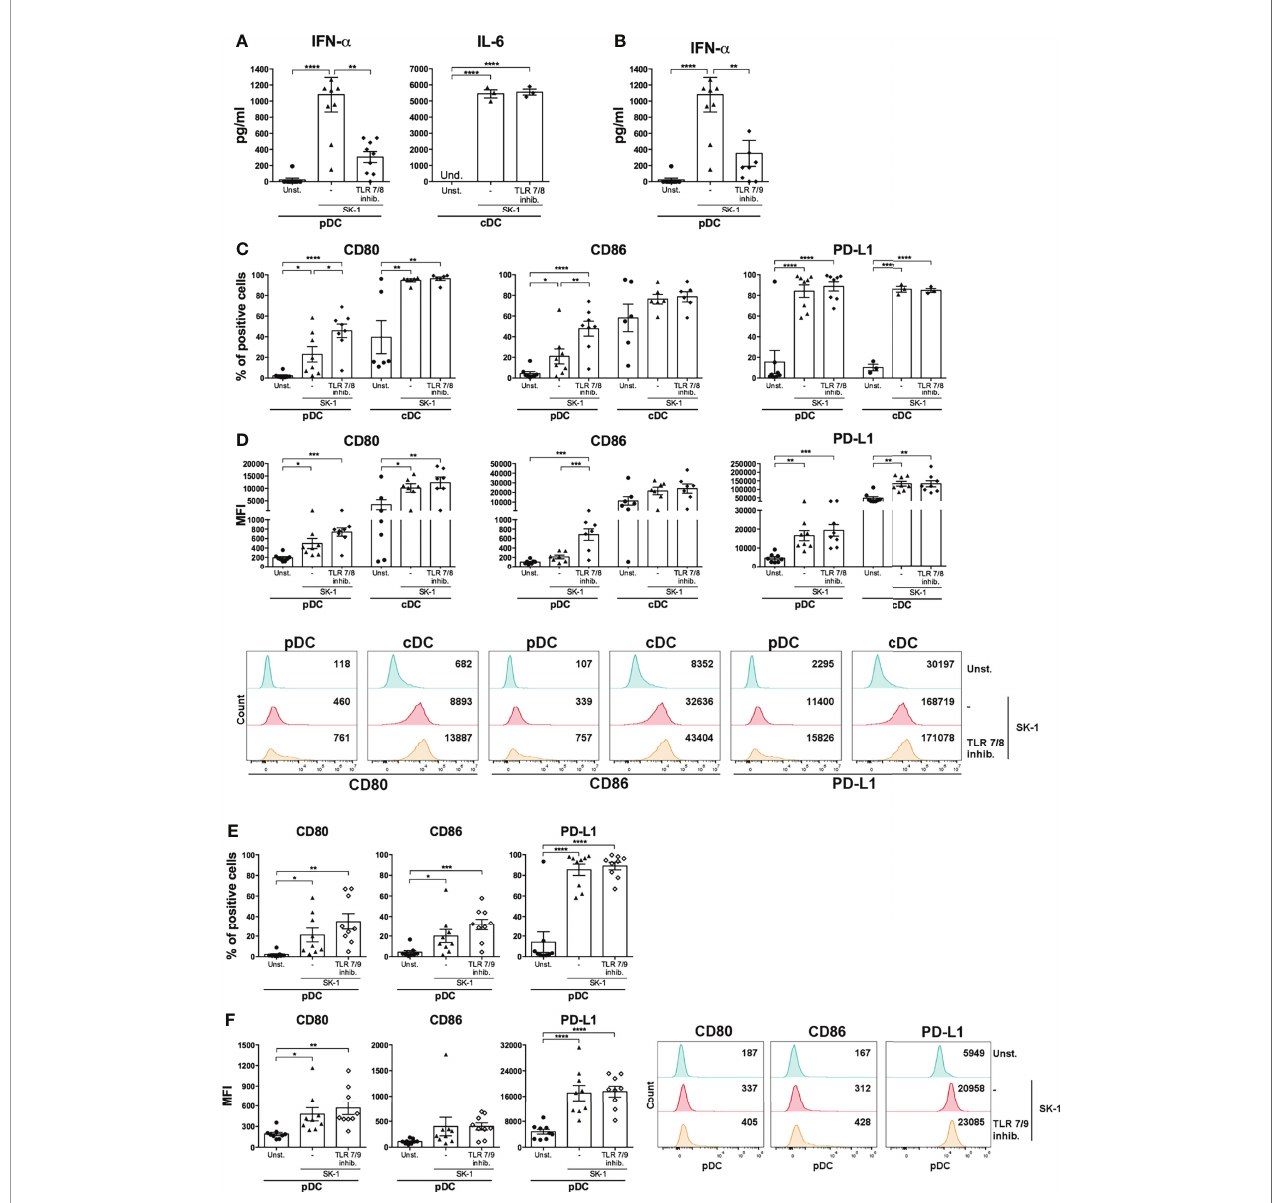
FIGURE 3 | IFN- a production by SK-1-stimulated plasmacytoid dendritic cells (pDCs) is mediated by sensors of nucleic acids. Human pDCs and conventional dendritic cells (cDCs) puri fi ed from the peripheral blood of healthy donors were pre-treated for 30 min with TLR 7/8 (1 m M) or with TLR 7/9 (1 m M) and cultured for 48 h without stimulation (Unst.) or with the laboratory strain of Saccharomyces cerevisiae SK-1 at multiplicity of infection = 5 (SK-1/DC). The levels of IFN- a or IL-6 were measured in the culture supernatants by ELISA (A, B) . The expression of molecules CD80, CD86, and PD-L1 was analyzed by fl ow cytometry and reported as the percentage of positive cells and median fl uorescence intensity (C – F) . The graphs show the mean ± SEM of three or more independent experiments, each from different donors. Two- way ANOVA was used to compare different experimental conditions (*= p -value ≤ 0.05; **= p -value ≤ 0.01; ***= p -value ≤ 0.001; ****= p -value ≤